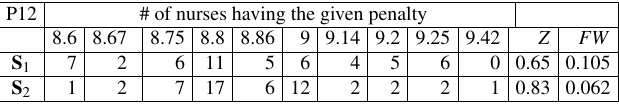
Table 6. Comparison of two solutions on the instance P12. P12